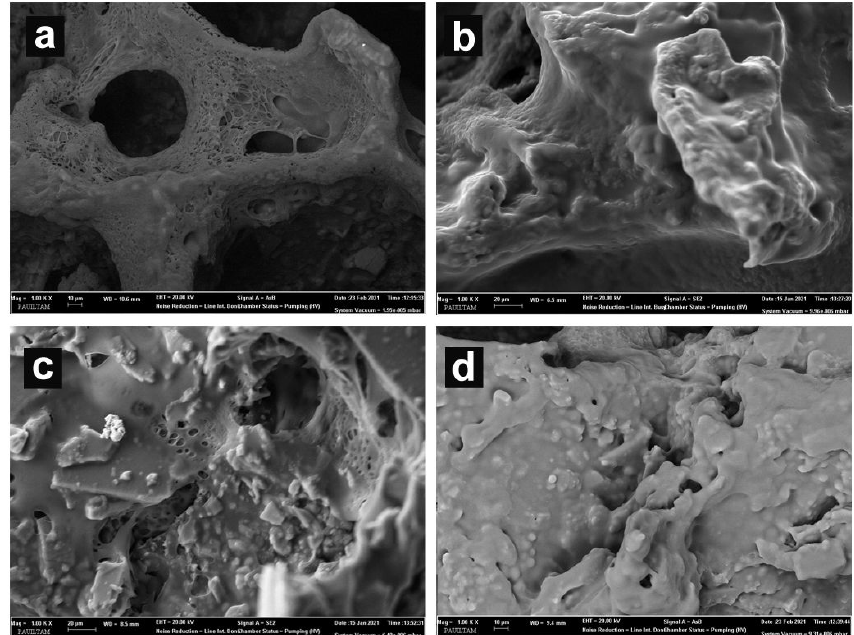
Figure 5. SEM images of diatom-free BTS-1 (a) and BTS-3 (c) scaffolds and diatom-doped BTS-2 (b) and BTS-4 (d) scaffolds with 3T3 cells after 8 days of cell culture.